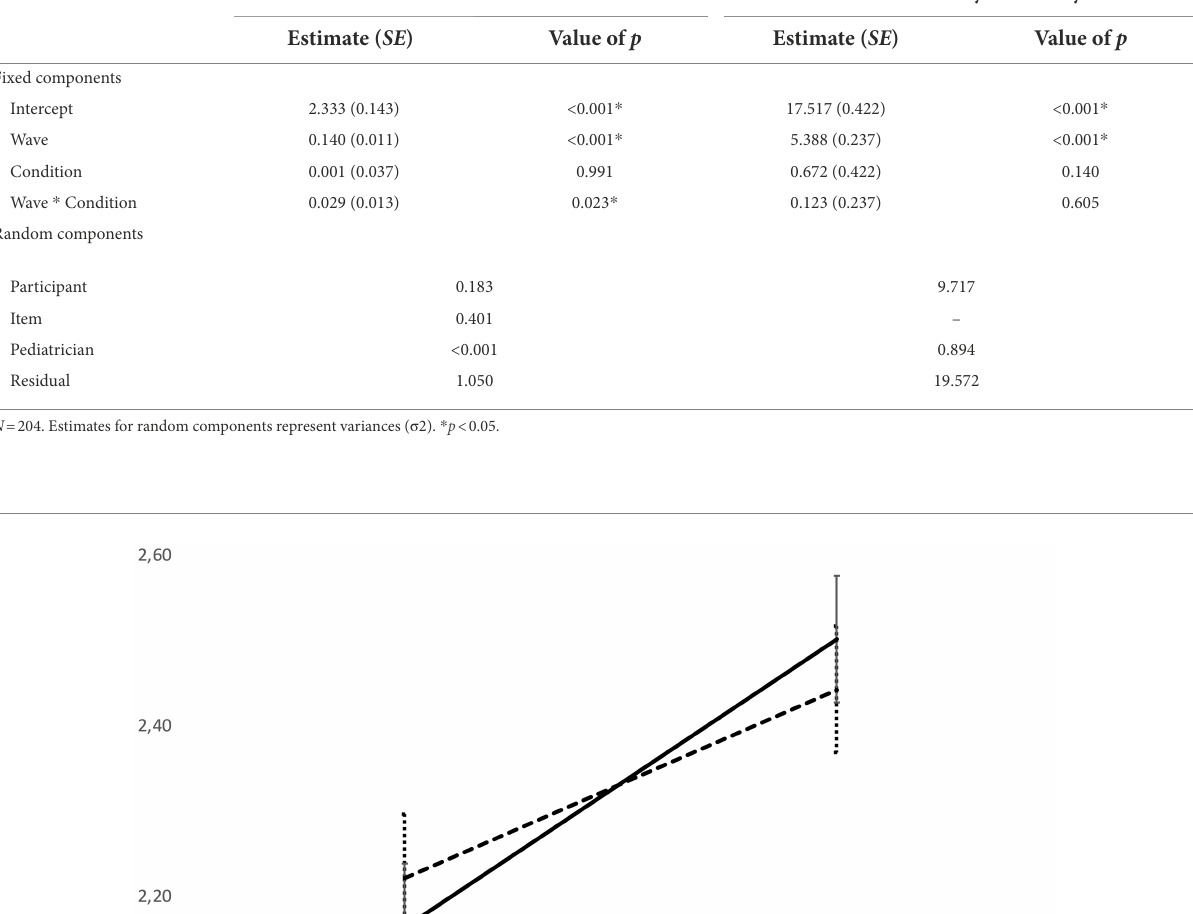
between condition and wave emerged ( β = 0.029, SE = 0.013,